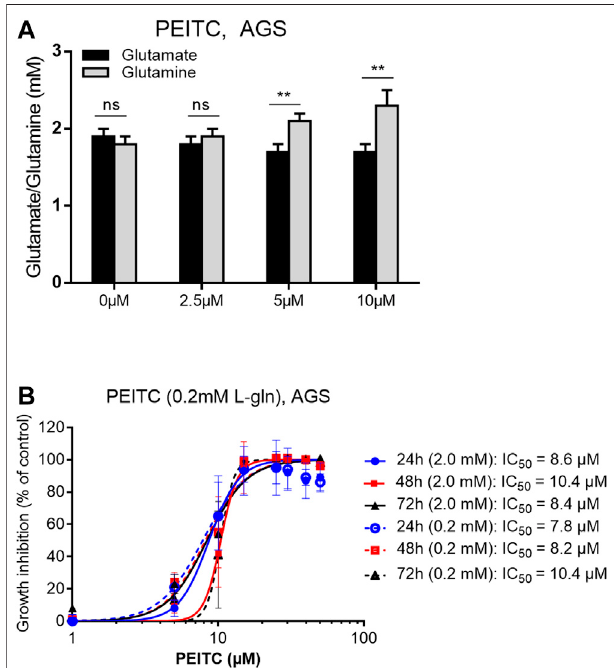
FIGURE 4 | Glutamate/glutamine determination upon 6 h treatments with 0, 2.5, 5 or 10 µM PEITC on AGS cells (A) . PEITC treatment in L-glutamine-reduced ( × 10) DMEM medium (B) . Mean ± SD. Paired t -test in (A) . ** p < 0.01; ns, not signi fi cant; PEITC, phenethyl isothiocyanate; L-gln,